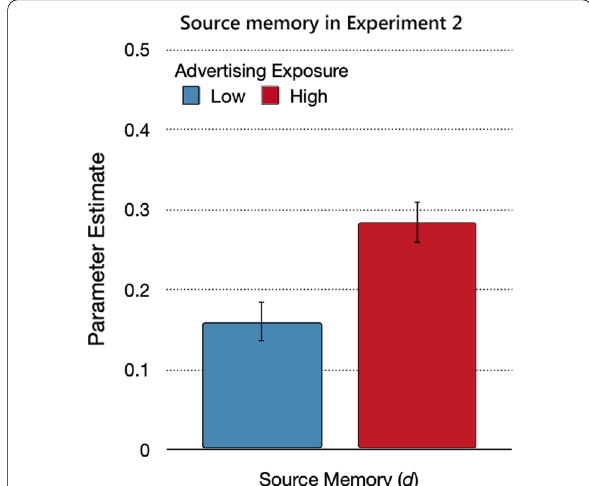
Fig. 6 Source memory in Experiment 2. Note : Parameter estimates of the source memory parameter d , reflecting the probability of correctly remembering the source of the statements from the advertising and trustworthy sources, as a function of advertising exposure (low, high). The error bars reflect standard errors